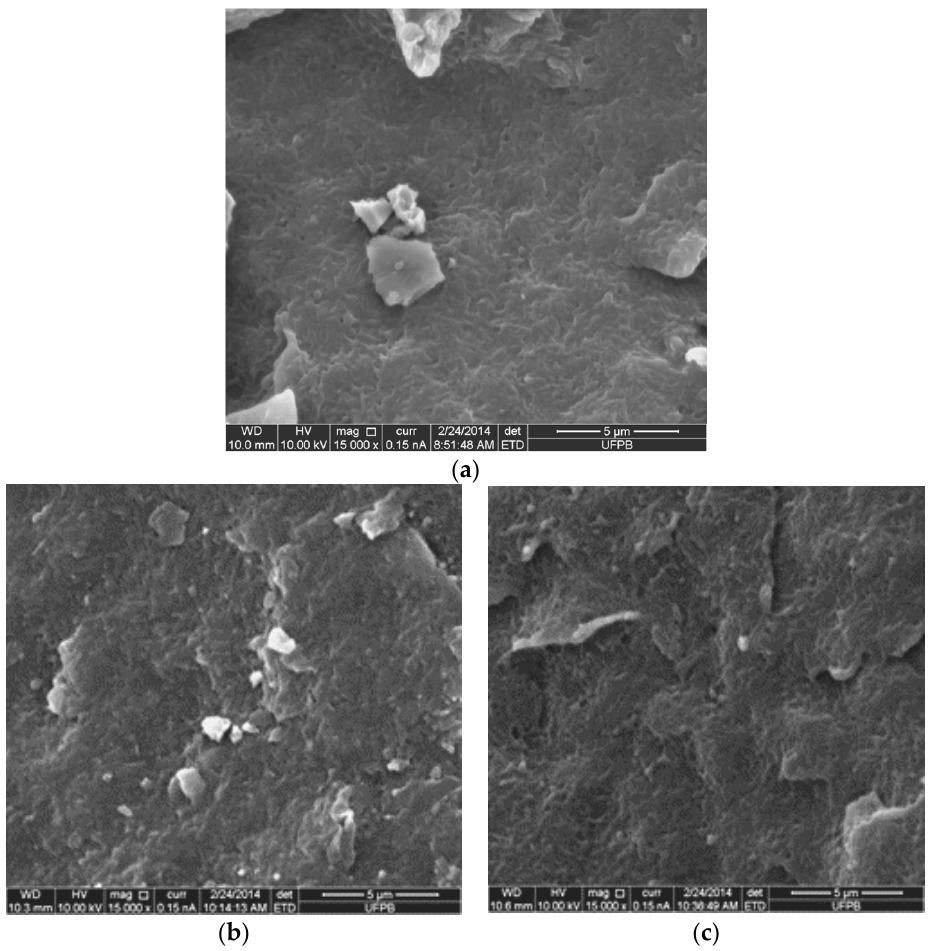
Figure 5. Scanning electron micrograph of ( a ) HDPE/CS8; ( b ) HDPE/CS8/OBent E ; and ( c ) HDPE/CS8/OBent P .